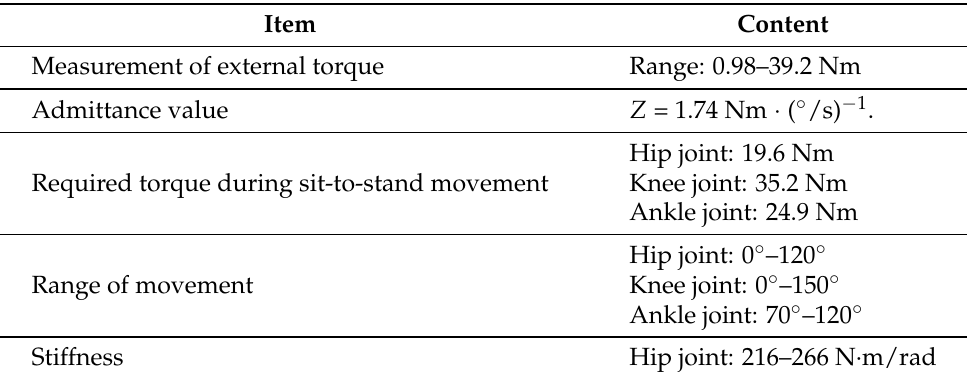
Figure 2. Process of STS transfer with the range of motion (ROM) and maximum angle shown. Table 1. Requirements of the robot